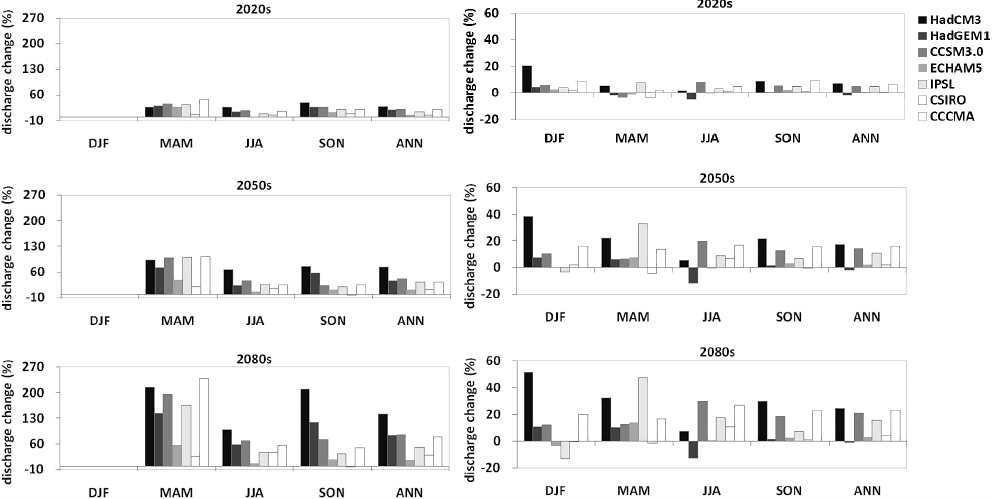
Figure 6. Seasonal and annual discharge changes for seven GCM projections for the 2020s, 2050s and 2080s time horizons for the rivers Huangfuchuan (left) and Xiangxi (right) (compared to the 1961–1990